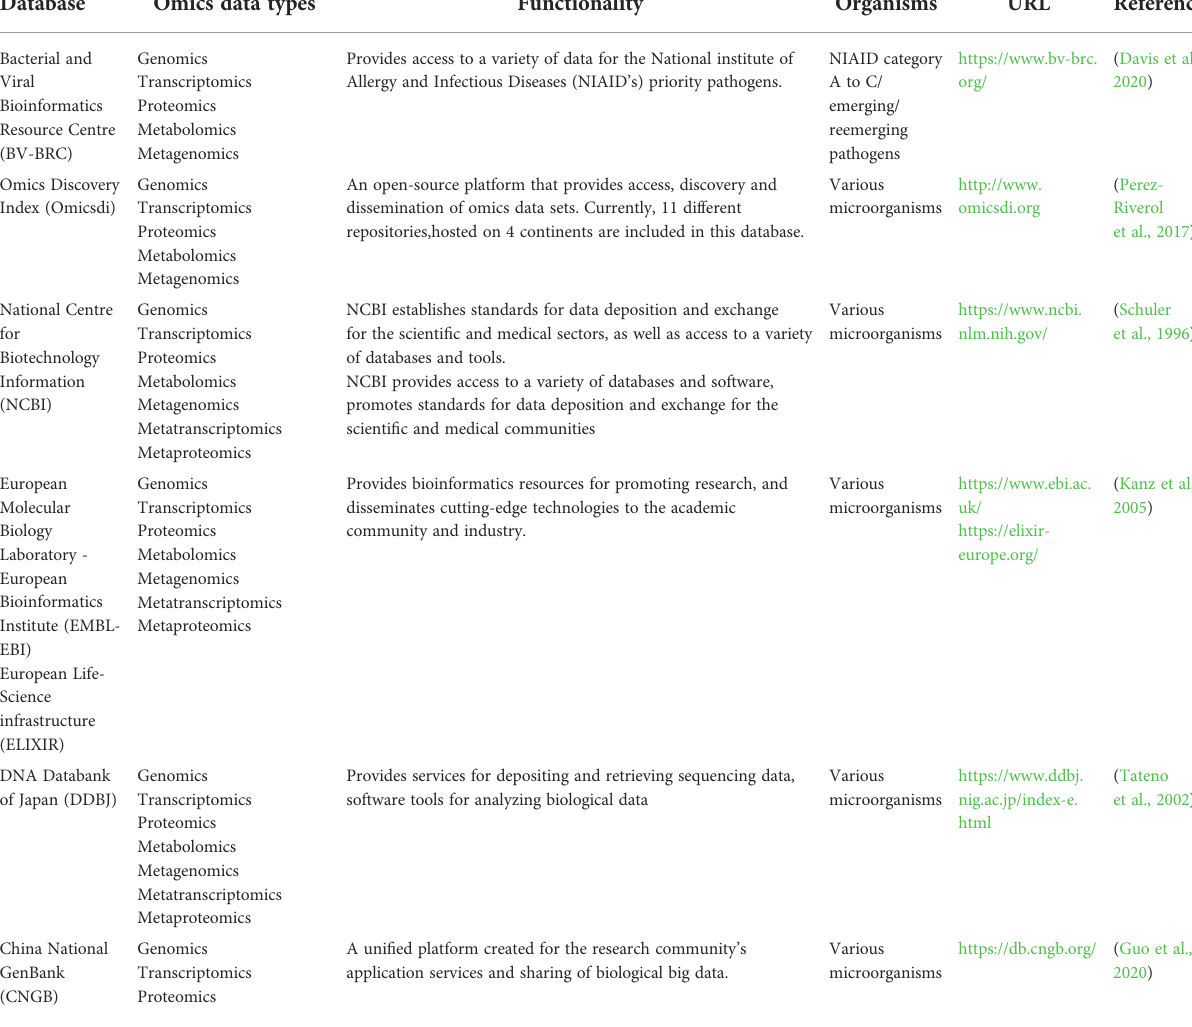
TABLE 1 Prominent microbiological databases and resources available for data